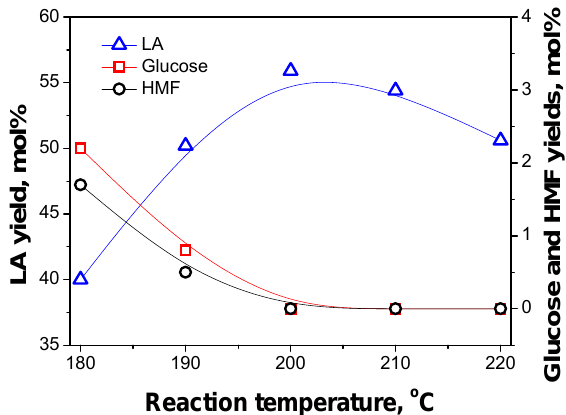
Figure 8. Effect of reaction temperature on yields of products.